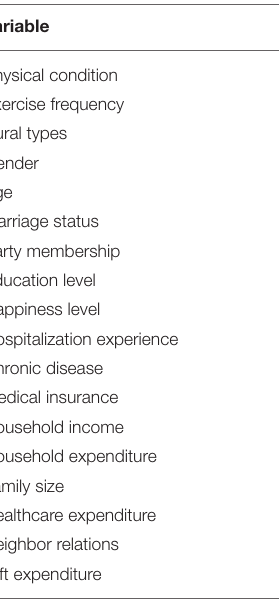
TABLE 2 | Descriptive statistics of